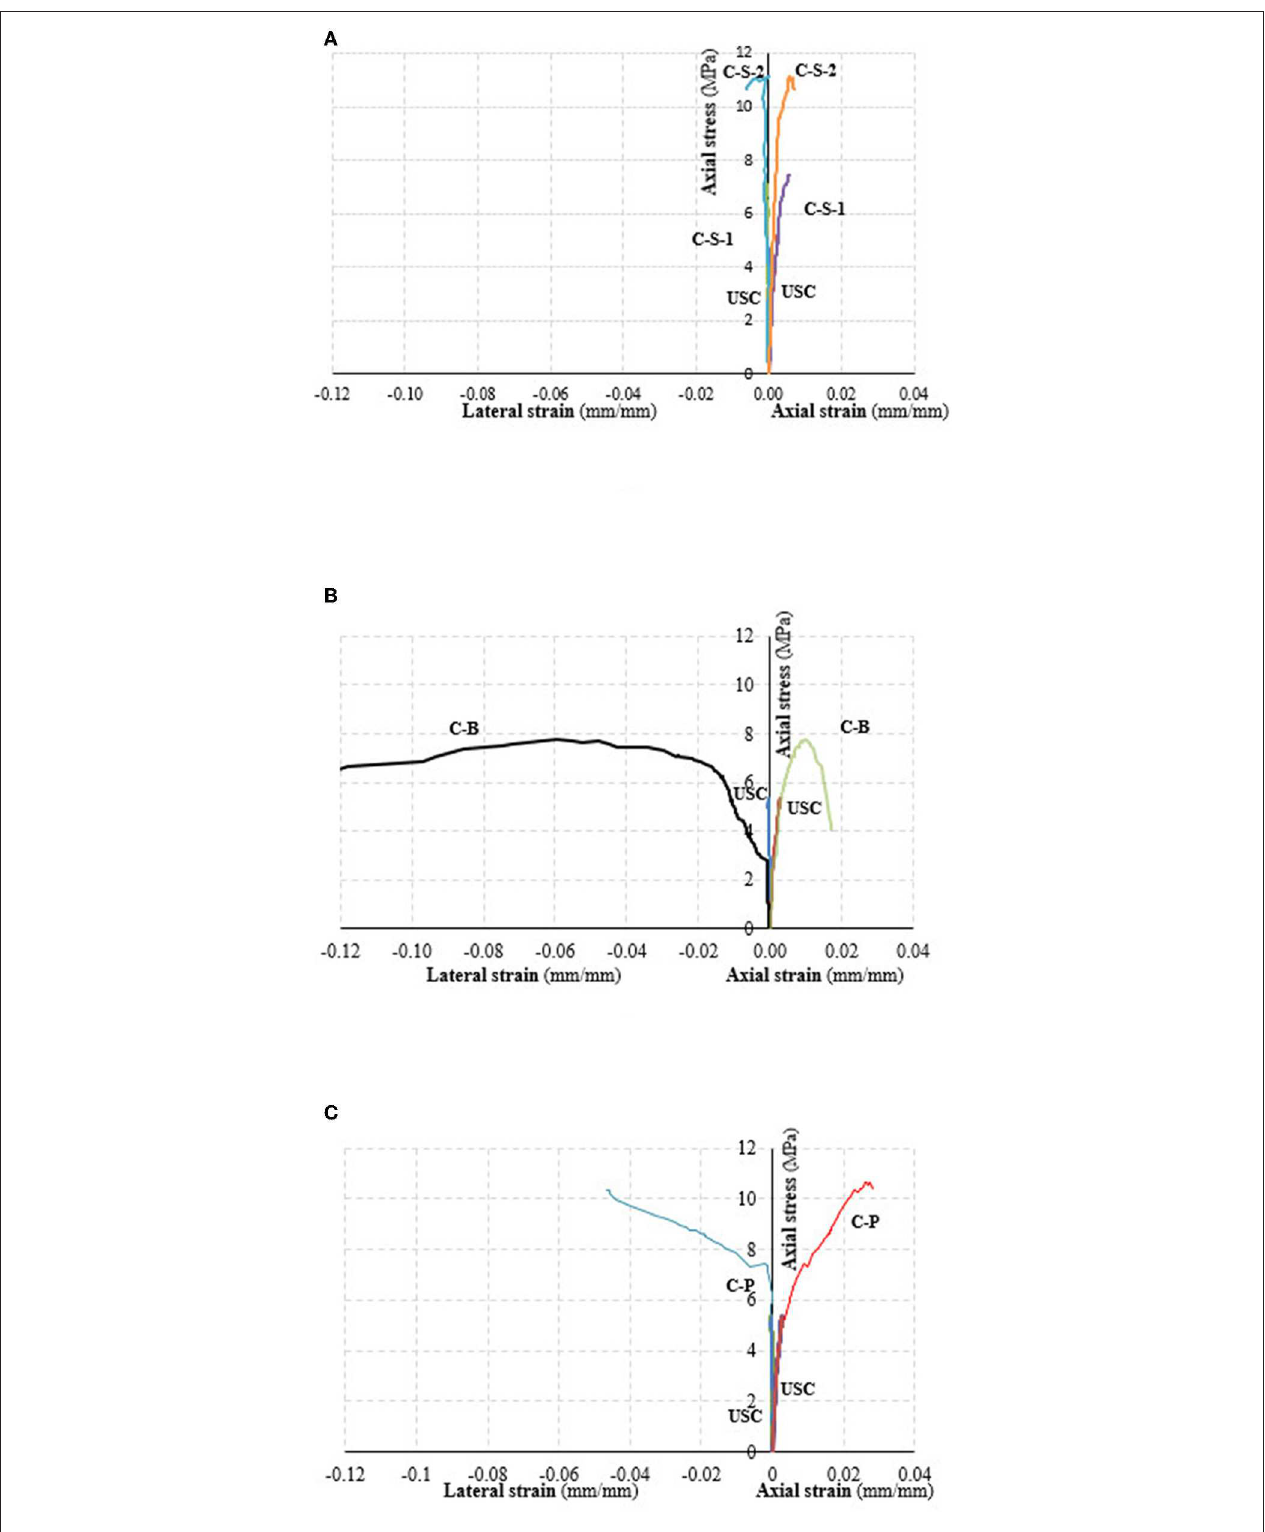
FIGURE 10 | Axial stress-strain curves of confined columns: (A) SRG, (B) Basalt-FRCM, and (C) PBO-FRCM.